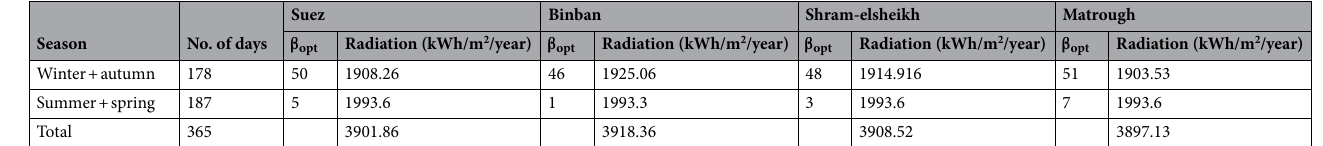
Table 4. Case 4: two optimal angles for the